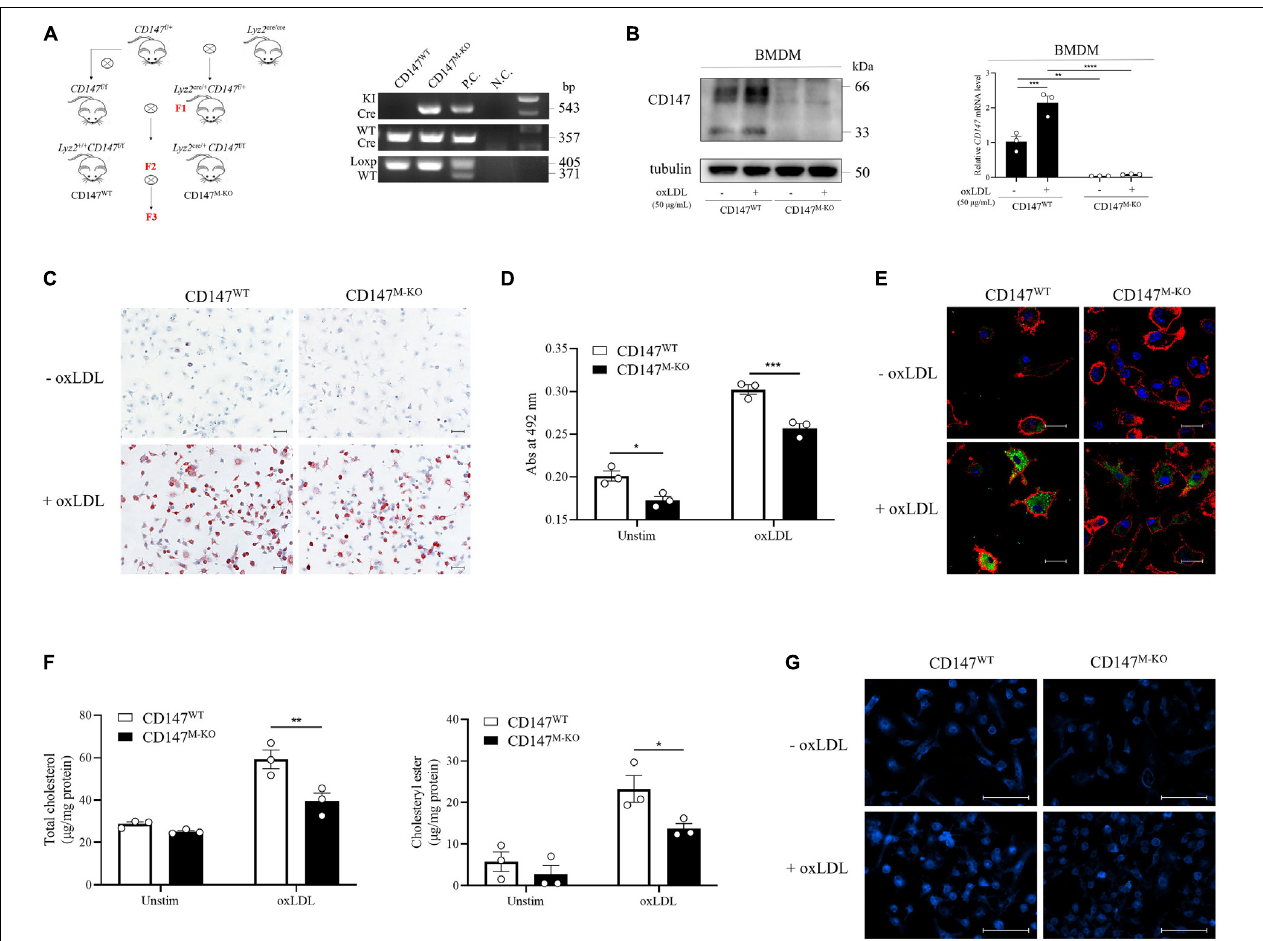
FIGURE 4 | Macrophage-specific CD147 knockout inhibits foam cell formation. (A) Generation of macrophage-specific CD147 knockout mice ( Lyz2 cre / + CD147 f / f , namely, CD147 M − KO mice) is illustrated by the mating scheme. The control WT littermates were Lyz2 + / + CD147 f / f , namely, CD147 WT mice. PCR analysis of genomic DNA showed the genotyping. The fragments from top to bottom are the KI Cre gene, WT Cre gene, and floxed and WT CD147 gene. Genomic DNA from Lyz2 cre / + mice was used as the P.C. for Cre analysis. Genomic DNA from CD147 f / + mice was used as the P.C. for CD147 analysis. H 2 O was used as the N.C. (B) Characterization of BMDMs isolated from CD147 WT or CD147 M − KO mice via western blotting and RT-PCR. (C) Representative images of Oil Red O staining of CD147 WT or CD147 M − KO BMDMs that were incubated with or without ox-LDL (50 µ g/mL) for 24 h. The scale bar is 50 µ m. (D) For quantification, Oil Red O absorbance was measured at 492 nm after extraction with isopropanol. (E) BMDMs from CD147 WT or CD147 M − KO mice stimulated with or without ox-LDL (50 µ g/mL) for 24 h were stained with Bodipy (lipids, green), F4/80 (macrophages, red), and DAPI (nuclei, blue) and examined via confocal microscopy. The scale bar is 20 µ m. (F) The total cholesterol and cholesteryl ester contents were determined with a coupled enzyme assay. (G) Representative images of Filipin staining of BMDMs from CD147 WT or CD147 M − KO mice treated with or without ox-LDL (50 µ g/mL) for 24 h. The scale bar is 100 µ m. Data represent the mean ± SEM. of n = 3 biologically independent experiments. * P < 0.05, ** P < 0.01, *** P < 0.001, **** P <